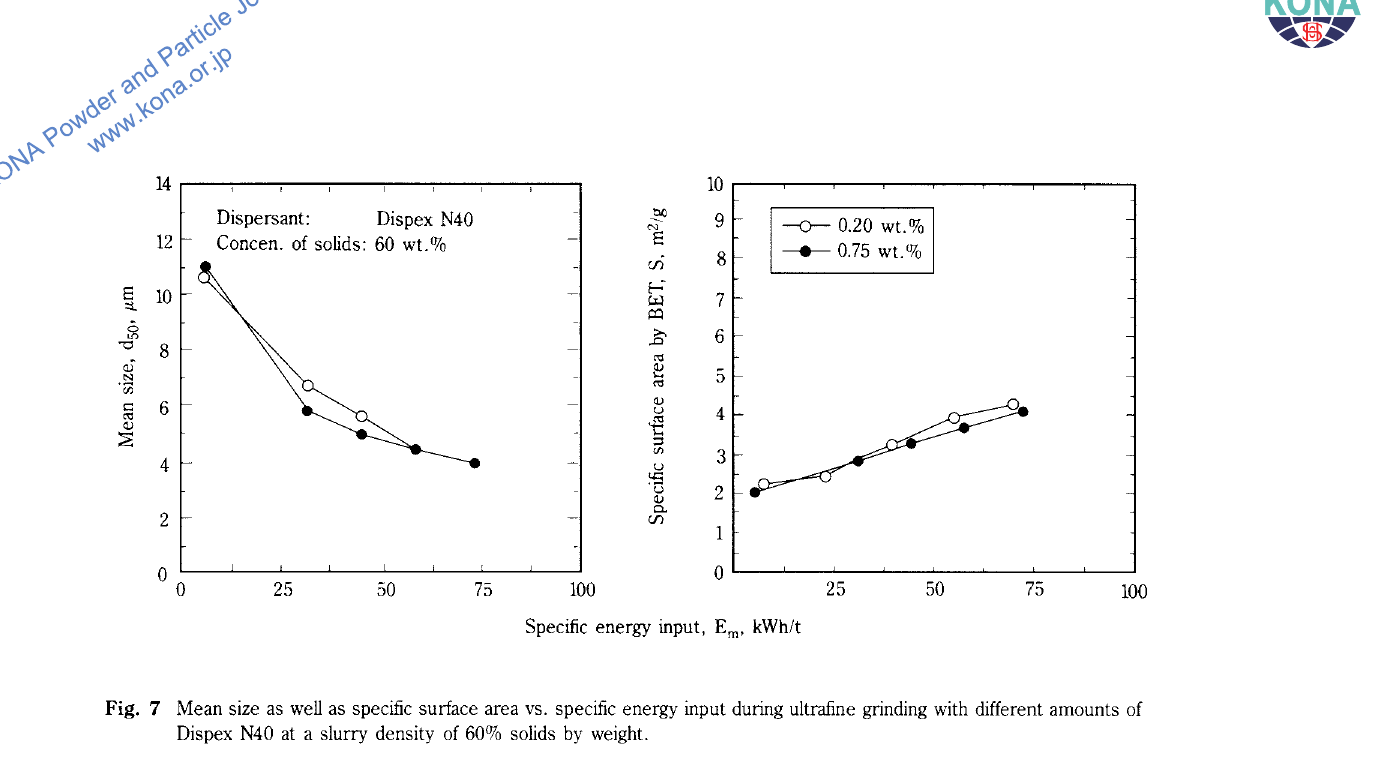
Fig. 7 Mean size as well as specific surface area vs. specific energy input during ultrafine grinding with different amounts of Dispex N40 at a slurry density of 60o/o solids by weight. 200 200 Concen. of solids: 70 wt.Ui(J Concen. of solids: 70 wt.%